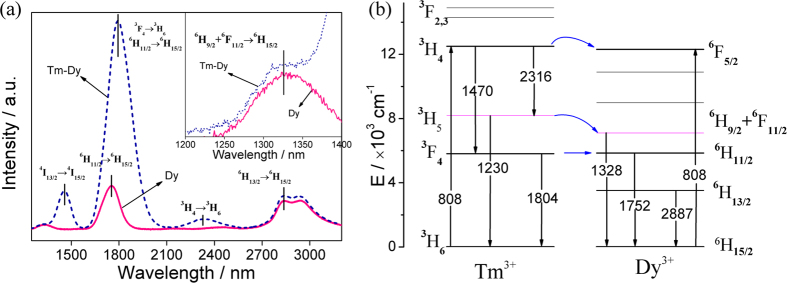
(a) The IR fluorescence spectra and (b) energy transfer scheme of 65GeS2–25In2S3–10CsI glasses doped with Dy3+- and Tm3+-Dy3+, respectively.